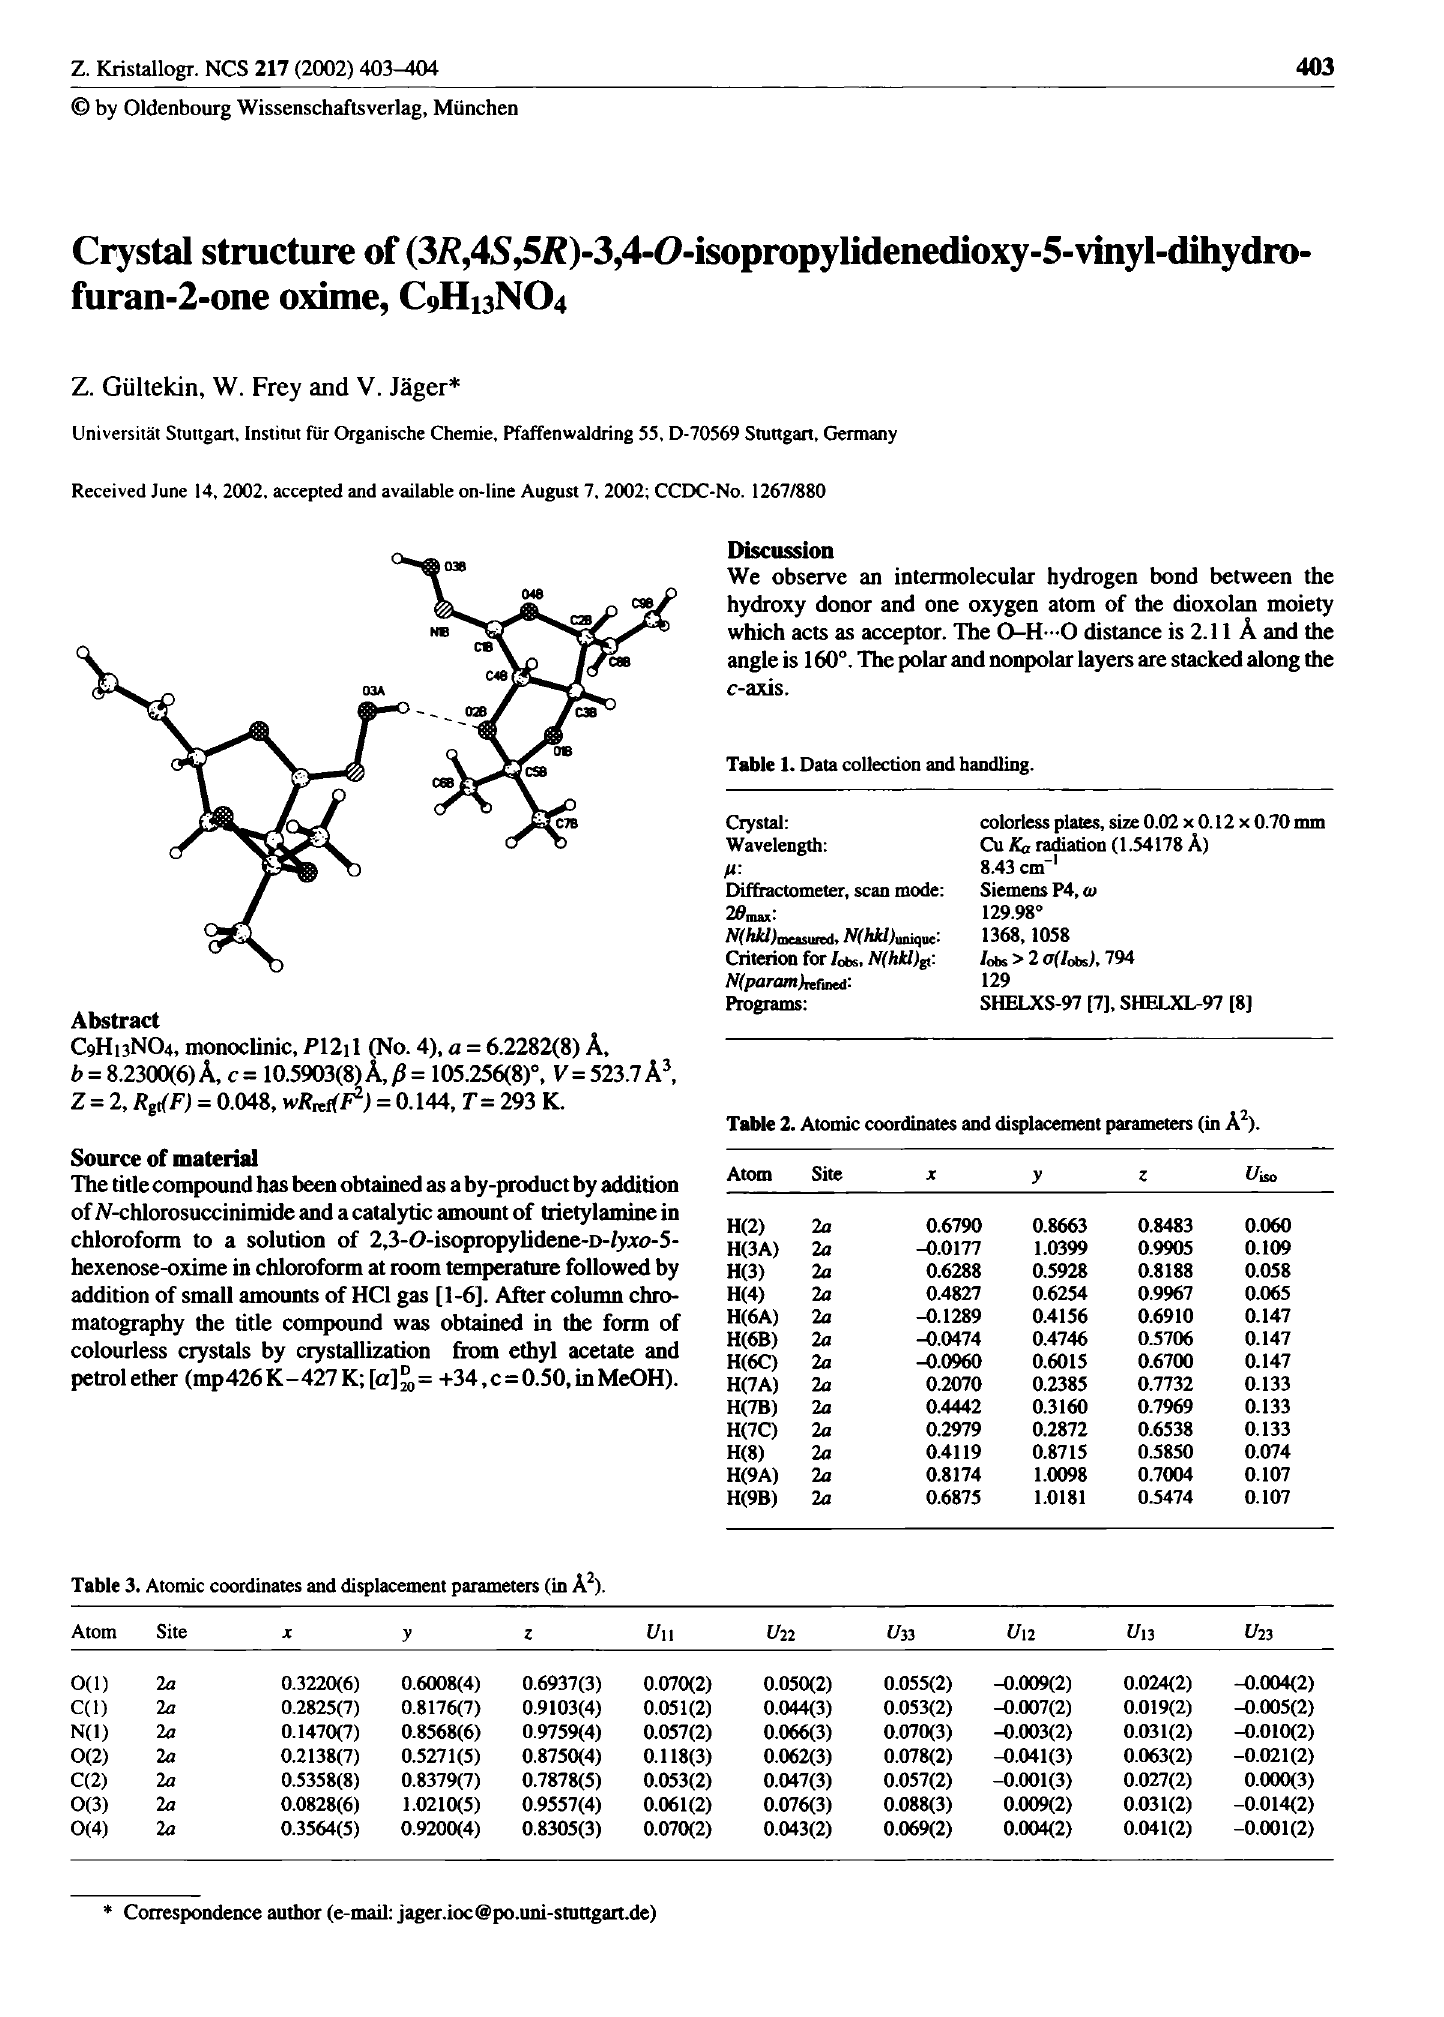
Table 3. Atomic coordinates and displacement parameters (in Â 2